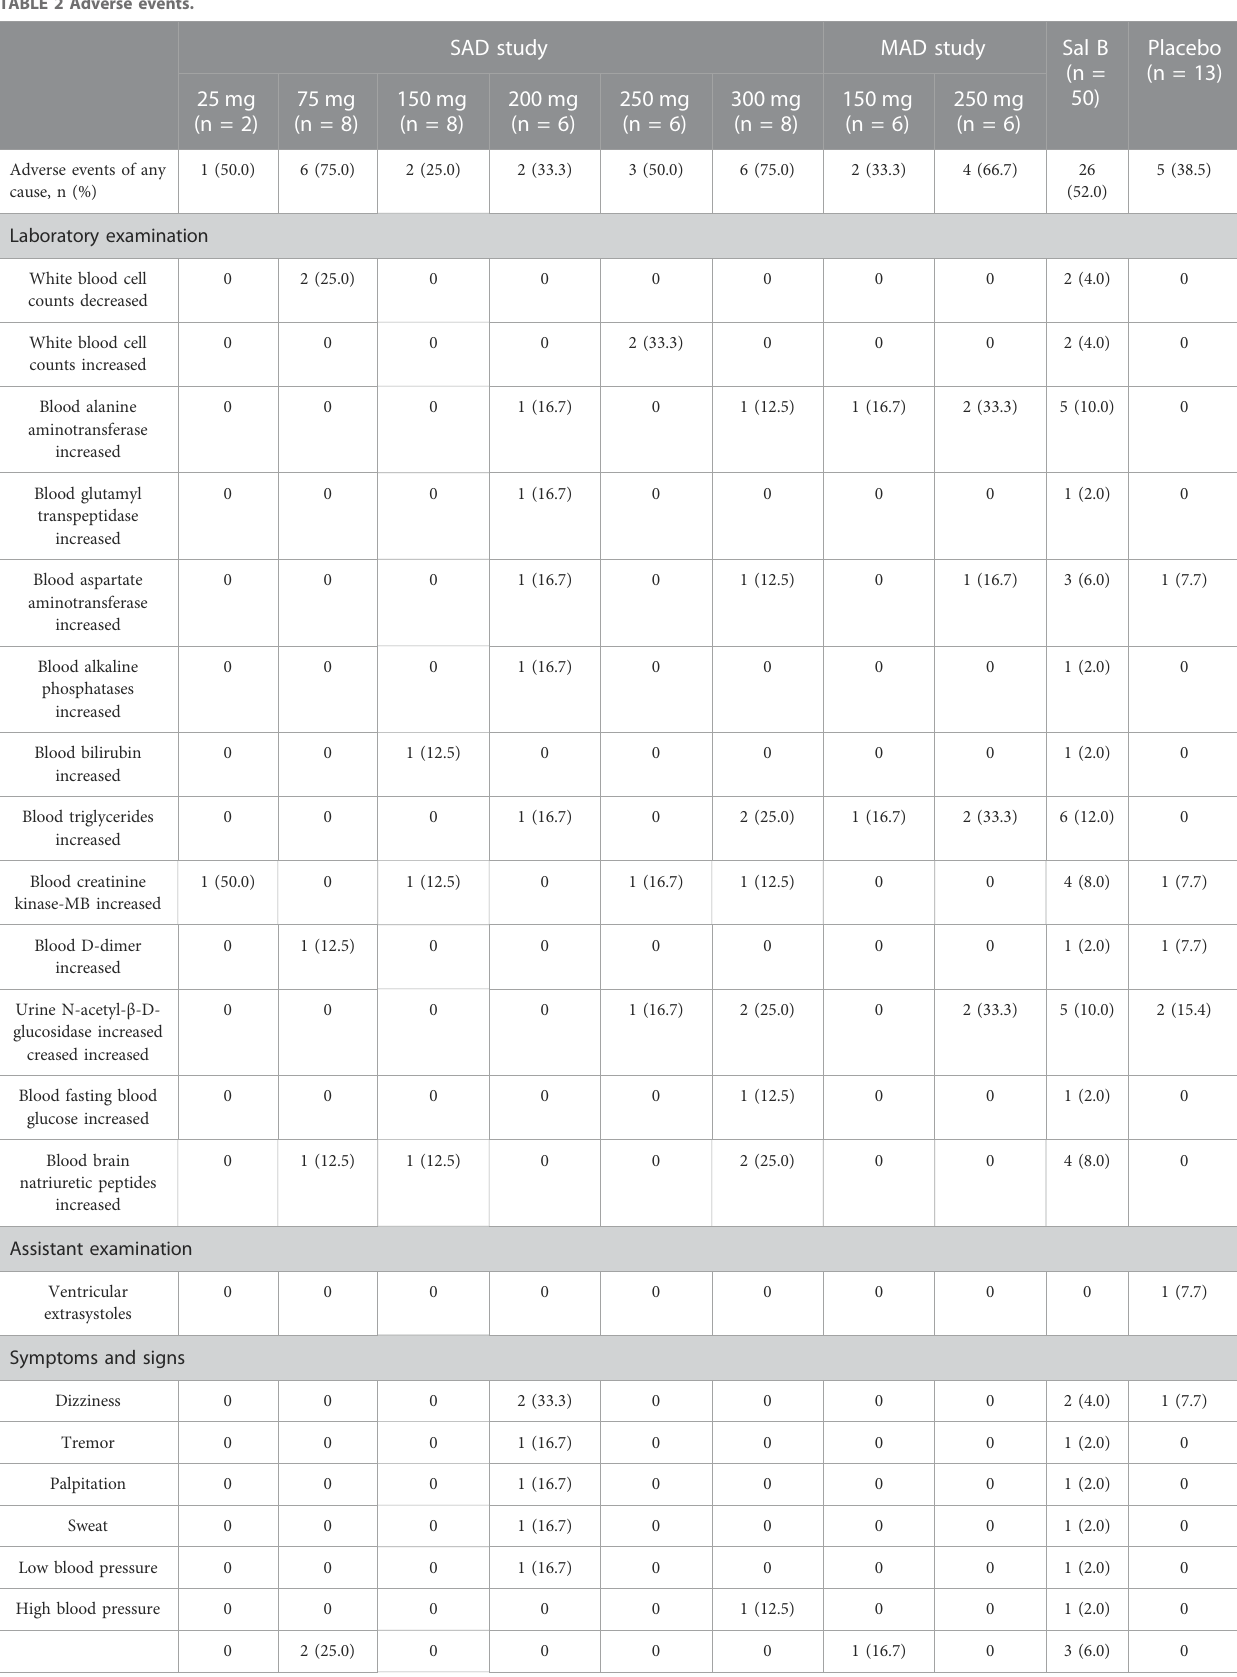
TABLE 2 Adverse